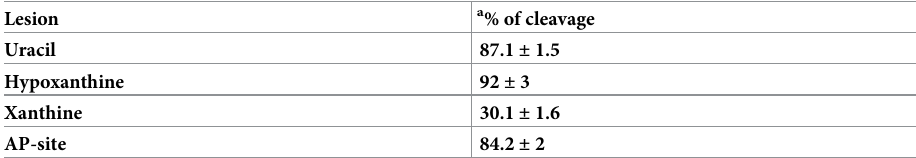
Table 1. Percentage of cleavage of different lesions by Bs